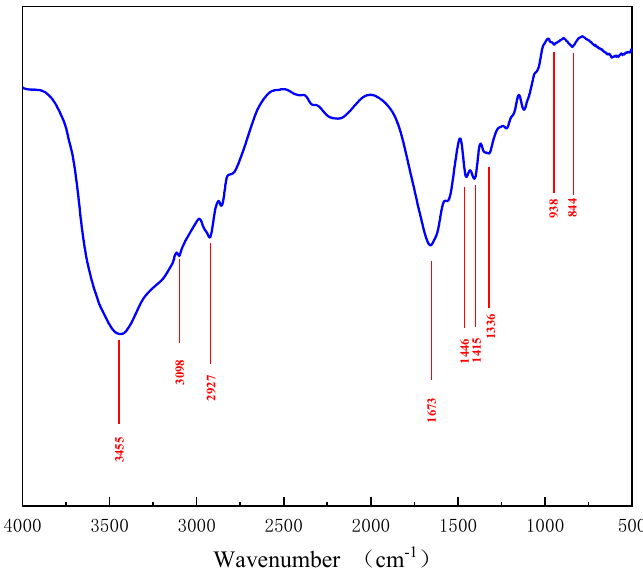
Figure 3. The FTIR spectrum of HGP.